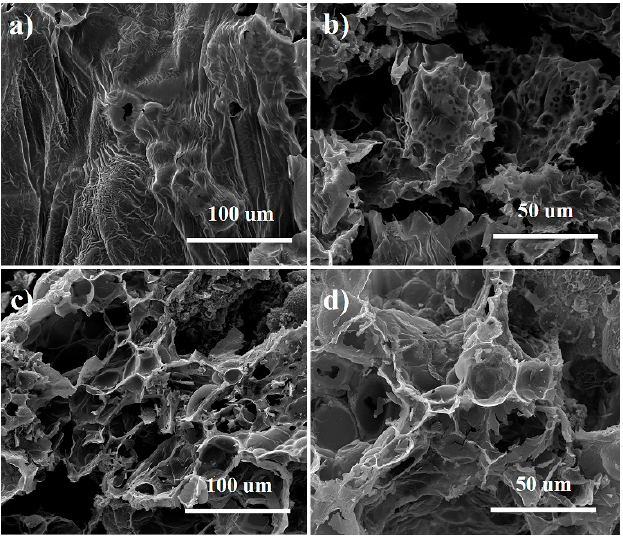
Figure 9. SEM photographs of char residues of mPP-IFR-10 fiber ( a , b ) and mPP-IFR-25 fiber ( c , d ) after burning.